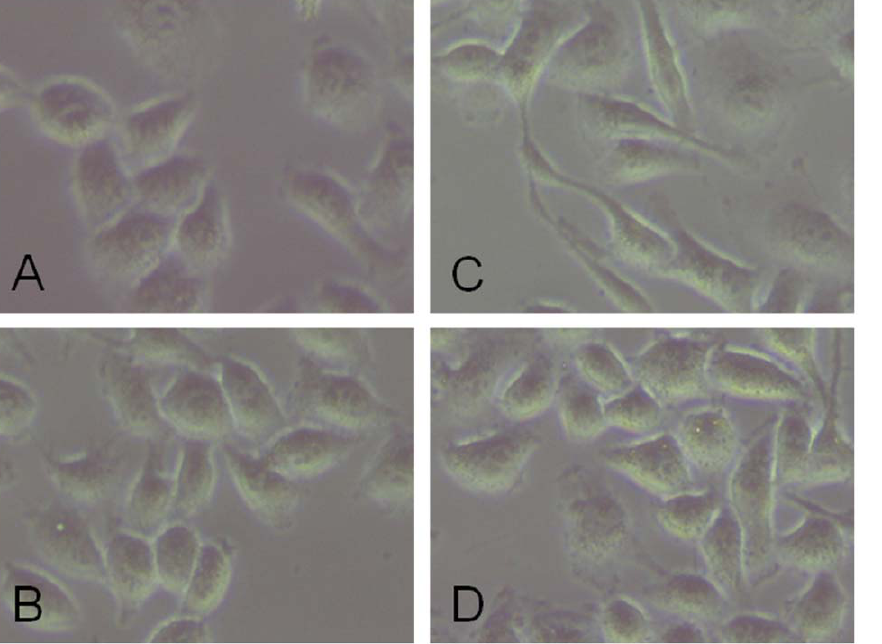
Figure 4. Inhibitory effect of pirfenidone on TGF- b 2-induced fibroblastic phenotypes in SRA01/04 cells. There was no apparent morphological change in SRA01/04 cells after 24 hours’ treatment with 0.5 mg/ml PFD only (B) compared with control cells(A). In the presence of 12.5 ng/ml TGF- b 2, the TGF- b 2-induced morphological changes in SRA01/04 cells (C) were detected, including elongated and spindle-like shapes, which were noticeably suppressed by co-treatment with 0.5 mg/ml PFD